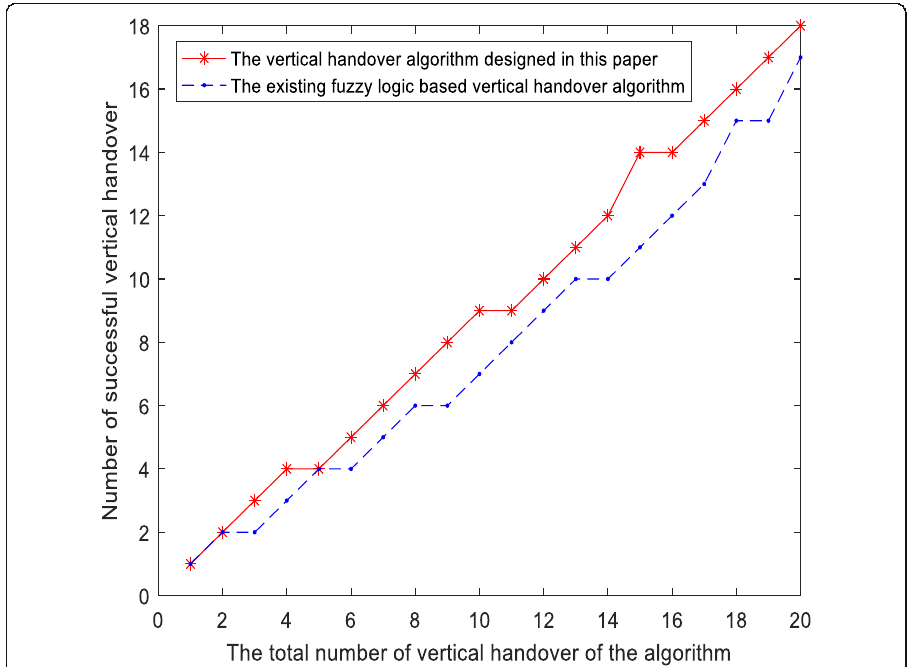
Fig. 13 Comparison results of different kinds of